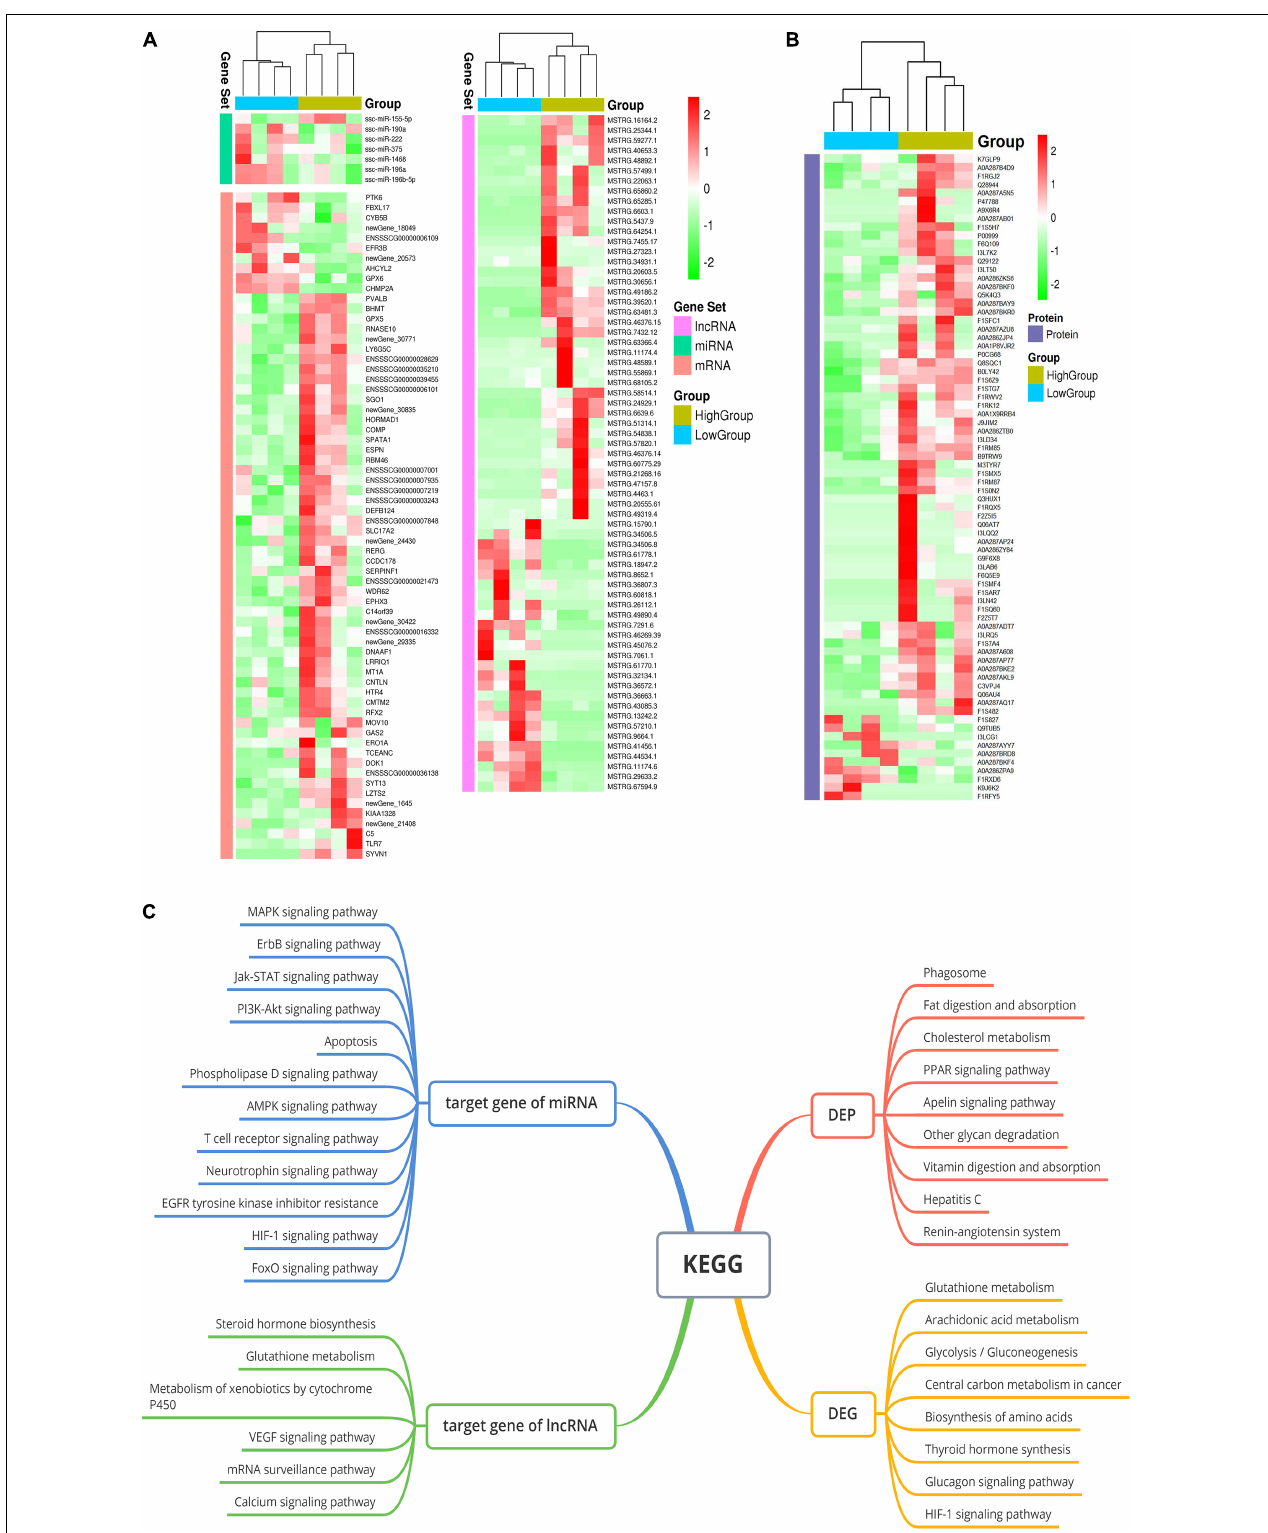
FIGURE 2 | The whole-transcriptome profiles of the H-SPEV and L-SPEV groups. (A) Heatmap of the 7 DEMs, 126 DEGs and 67 DELs in SPEVs between the two groups. (B) Heatmap of 76 DEPs in SPEVs between the two groups. (C) GO and KEGG enrichment of DEGs, DEPs, DEM target genes and DEL target genes. The significant GO terms and KEGG pathways are shown in the